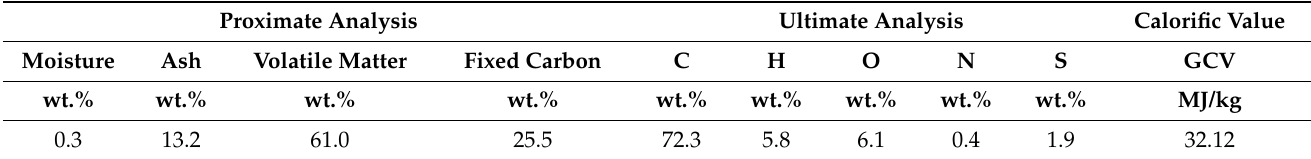
Table 1. Proximate analysis, ultimate analysis and calorific value of waste tire.